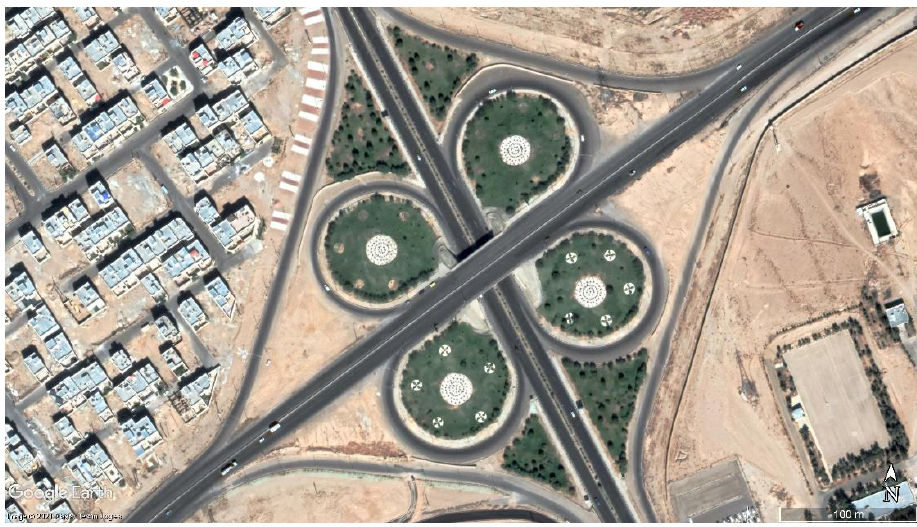
Figure 5. The bridge No. 1 on Google Earth (Latitude: 35°36′15″ N, Longitude: 53°22′16″ E).